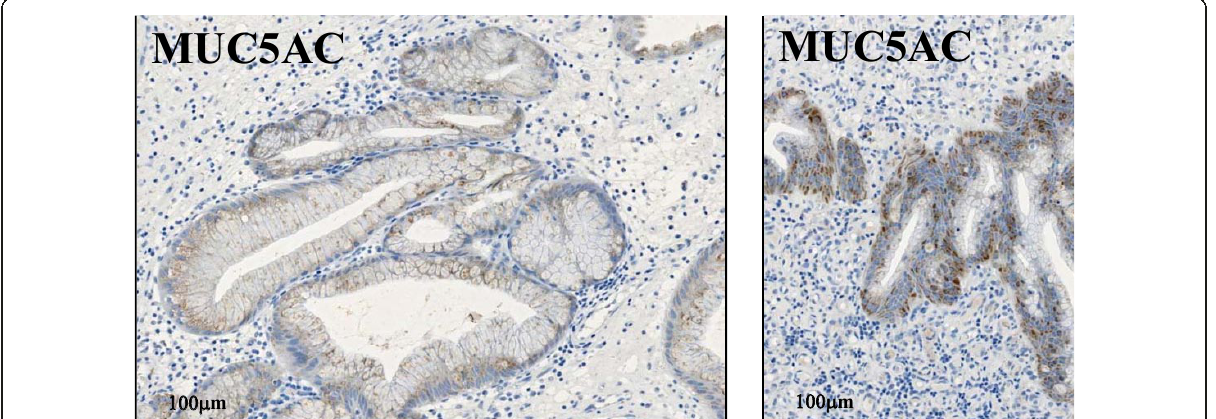
Figure 5 Microscopic examination of the adenocarcinoma arising in polyp by mucin immunohistochemical methods . Not only the hyperplastic (left) but the atypical (right) epithelium is also positive for MUC5AC in immunohistochemistry whereas negative for MUC2 or CD10, classified into pure gastric